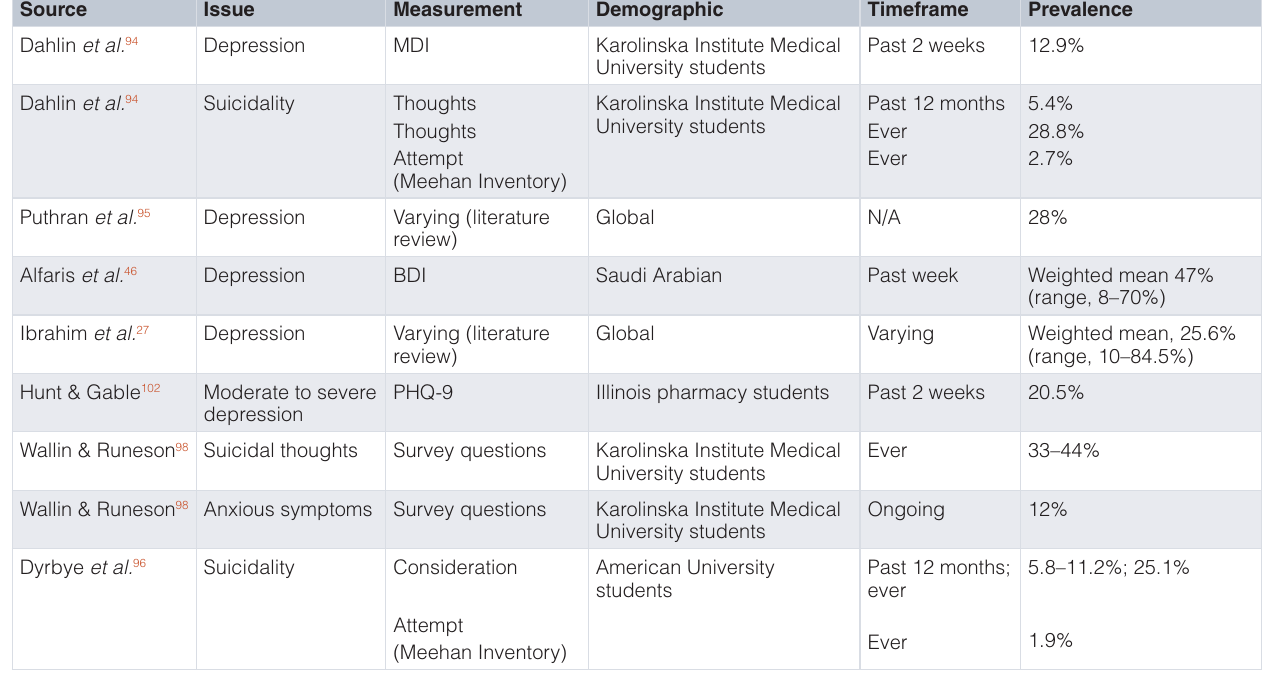
Table 8. Rates of depression, anxiety, distress, suicidality, and self-injurious behaviour among medical and health-studies students. Please refer to Table 1 for